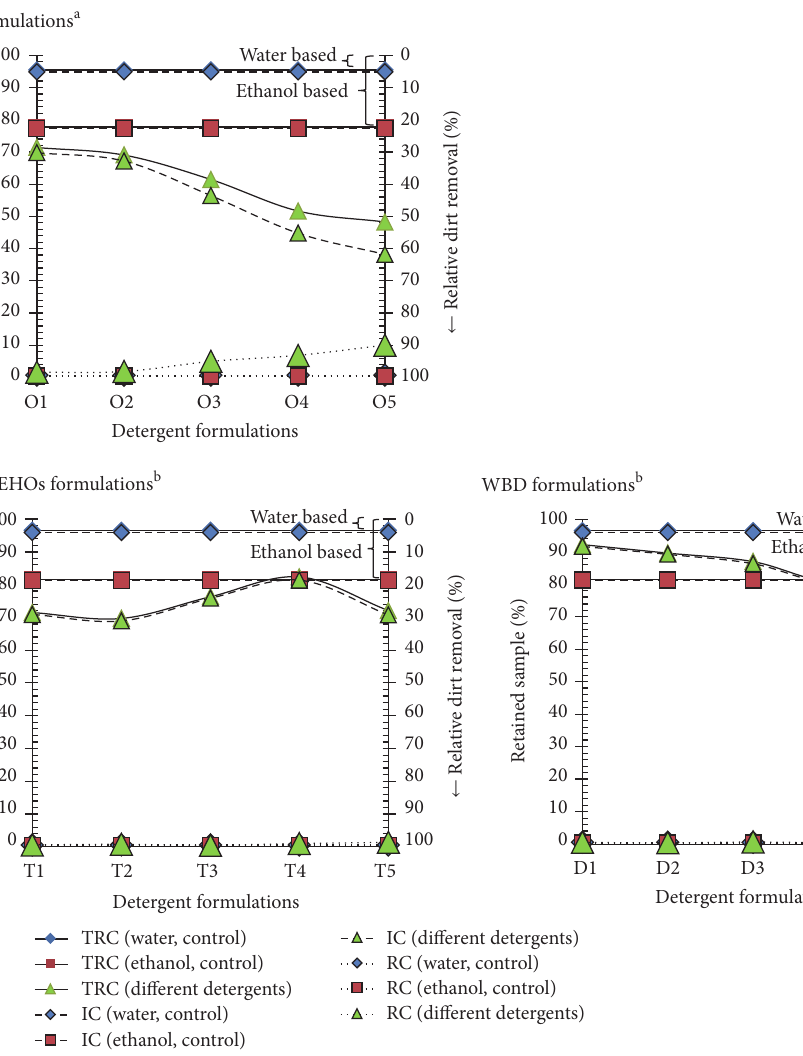
Figure 1:Effect of different detergent formulationson DBSCCwashed samples. Note: Detergent formulations arelistedin Table 2. a Processing temperature = 60 ∘ C; processing time = 1h; agitation speed = 200 revolutions per minute. b Processing temperature = 40 ∘ C; processing time = 1h; agitation speed = 200 revolutions per minute. RC contents of modified EHOs formulations and WBD formulations are overlapped with controls. Relative dirt removal represents the amount of dirt removed from IC and TRC samples in relation to unwashed cloth